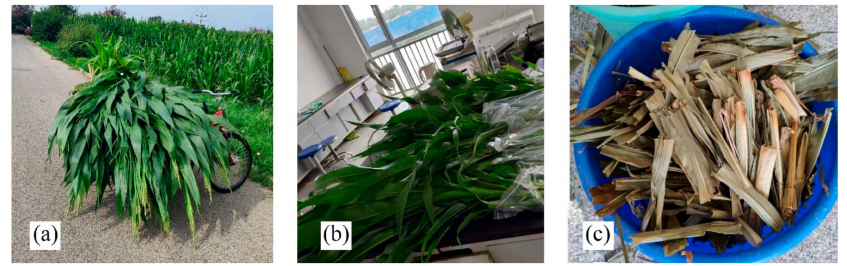
Figure 2. ( a ) Destructive ground sampling in the field; ( b ) measurements of the above-ground biomass (AGB) of fresh maize in the laboratory; ( c ) the AGB of dry maize after removing the moisture. − 1 − 1 The fresh AGB (t · ha ), dry AGB (t · ha ), and CH (cm) datasets generated are given in Table 2.